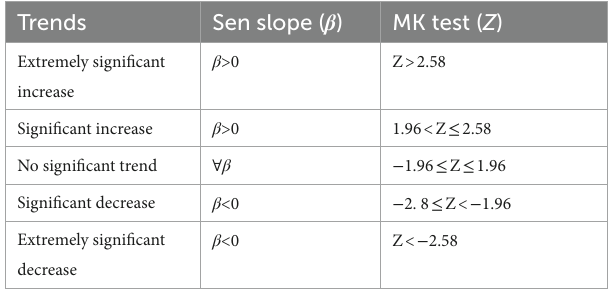
TABLE 2 Criteria for grading change